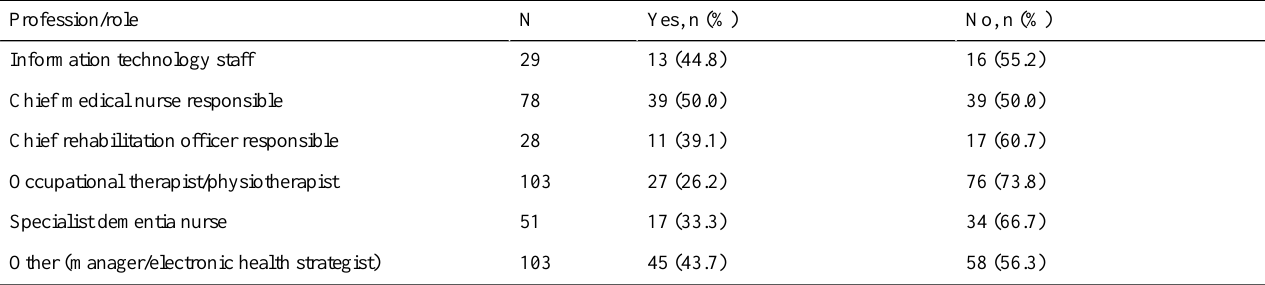
Table 3. Distribution of responses regarding continuous evaluation of potential welfare technology for future deployment in elder care in relation to profession/role (N=393).